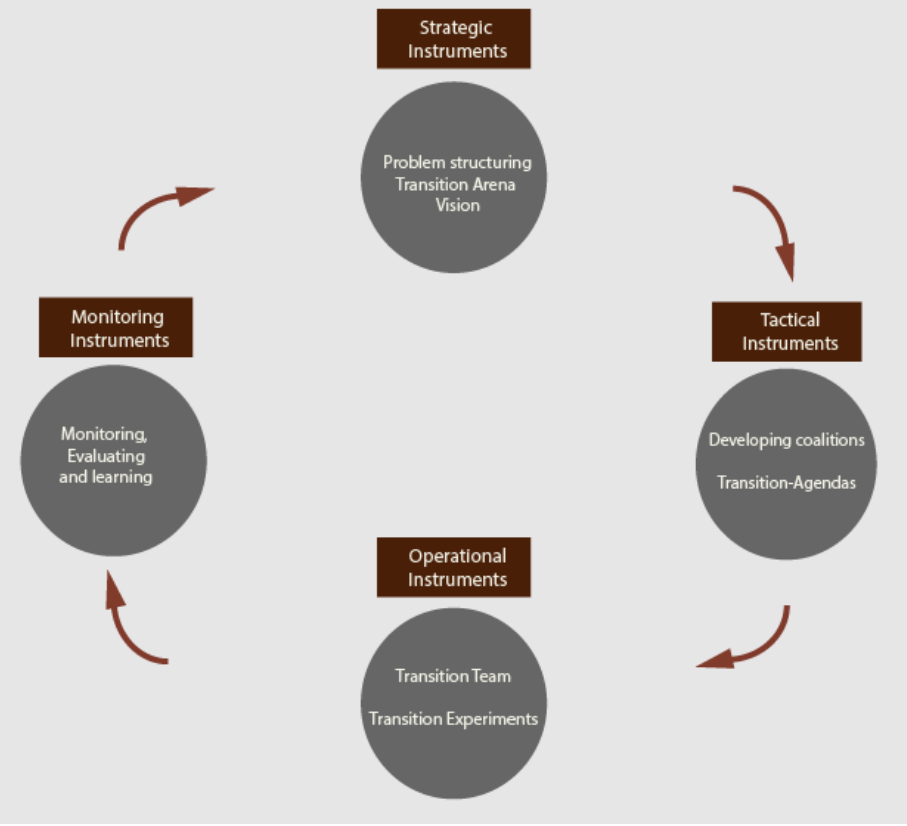
Figure 3. Transition Management Cycle. Elaborated by the authors based on Van den Bosh & Rotmans [13].